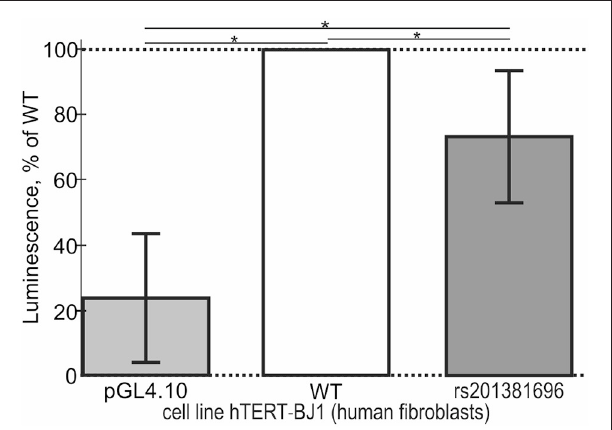
FIGURE 4 | Cell culture verification of the selected candidate SNP marker rs201381696 in cell line hTERT-BJ1 (human fibroblasts) transfected with the pGL 4.10 vector carrying a reporter LUC gene. Experimental data: open bars, ancestral allele (wild type, WT); two gray bars shown to the right and left of the open bar, namely, minor allele (rs201381696) and the original vector pGL 4.10 (Promega, USA) without any insertions, respectively, served as an independent control and minor allele, respectively. The height of the bars and their error bars correspond to the mean estimates and boundaries of their 95% confidence intervals calculated from 11 independent replicates of measurements. Asterisks indicate a statistically significant difference at the confidence level of α <